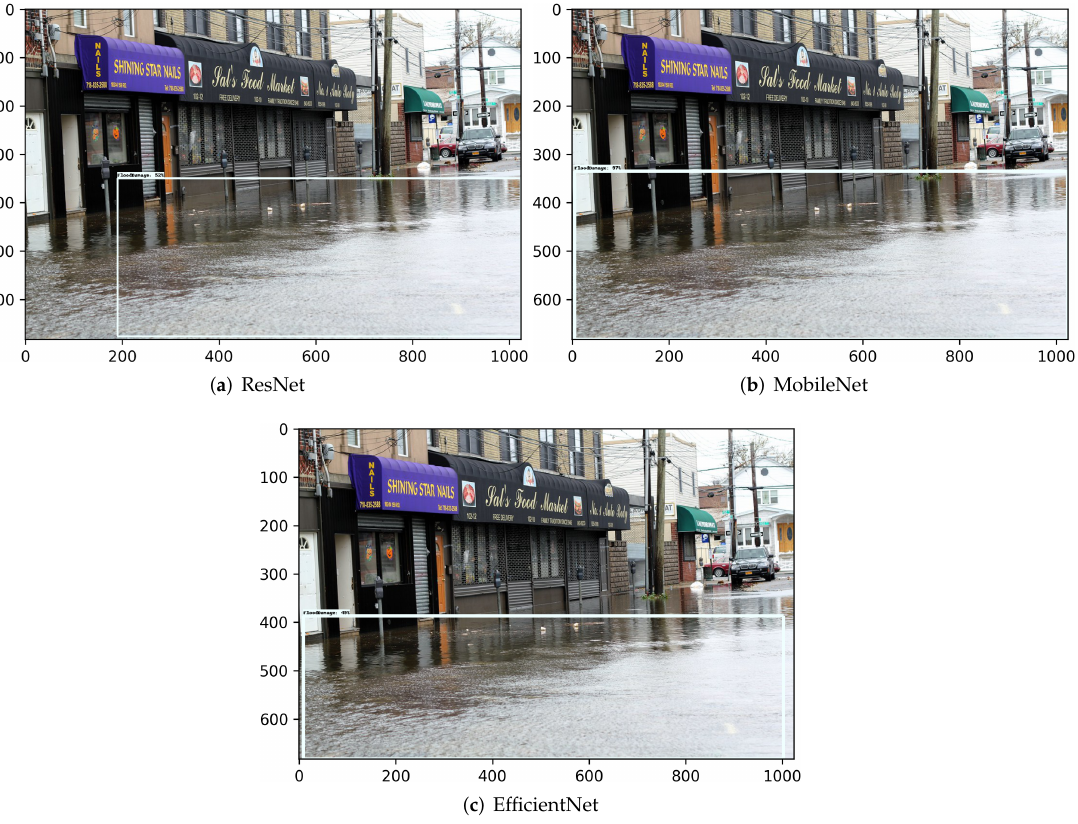
Figure 8. Inference carried out on the image of flood damage for each of the three models. The white bounding boxes correspond to the correct predictions of flood damage from the first row of Table 6.